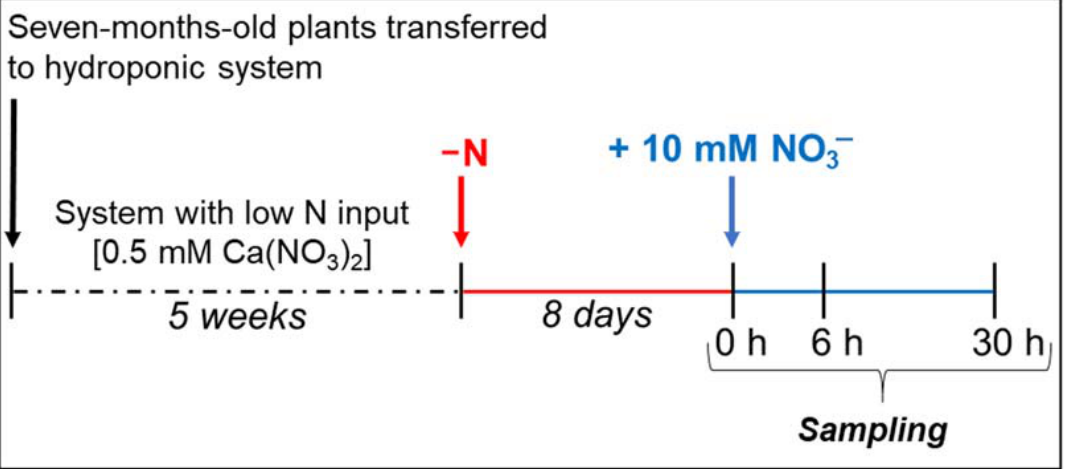
Figure 4. Growth experiment design and nutritional treatments. Further details are reported in the Material and